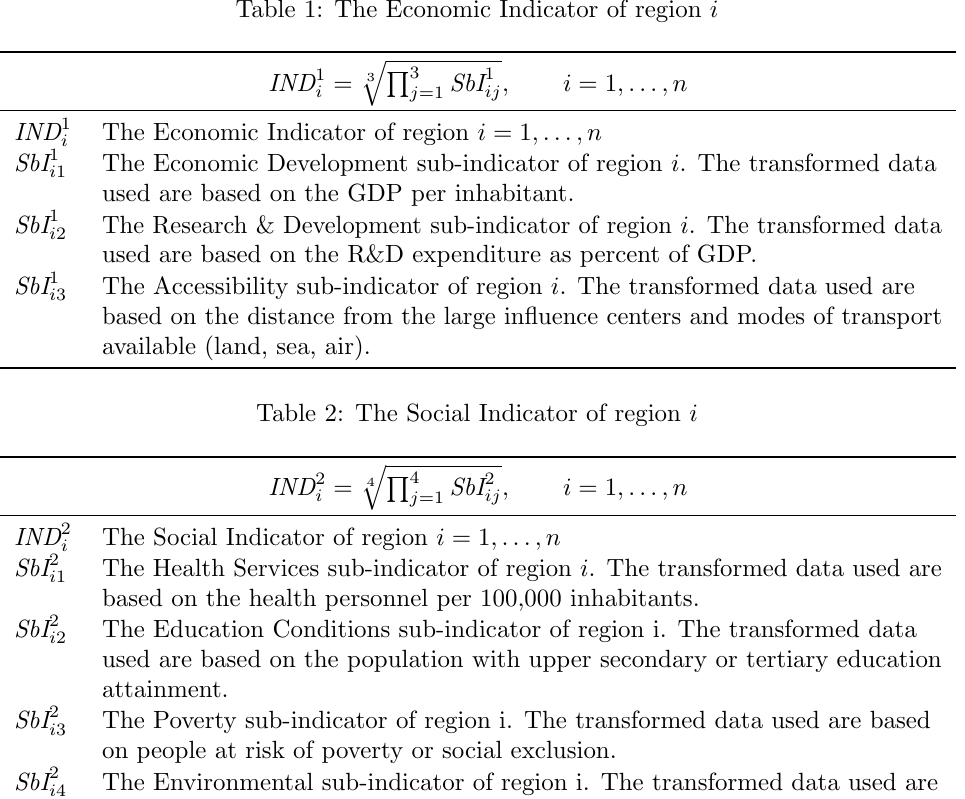
Table 1: The Economic Indicator of region i